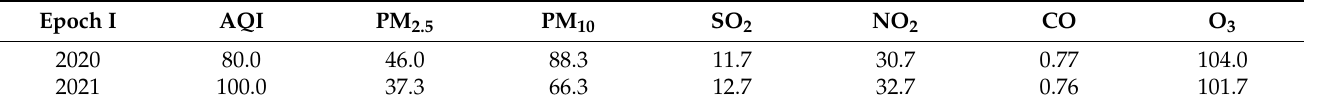
Table 5. Average values of air quality during the COVID epoch in 2020 (and the same epoch in 2021) ( µ g m –3 (CO (mg m –3